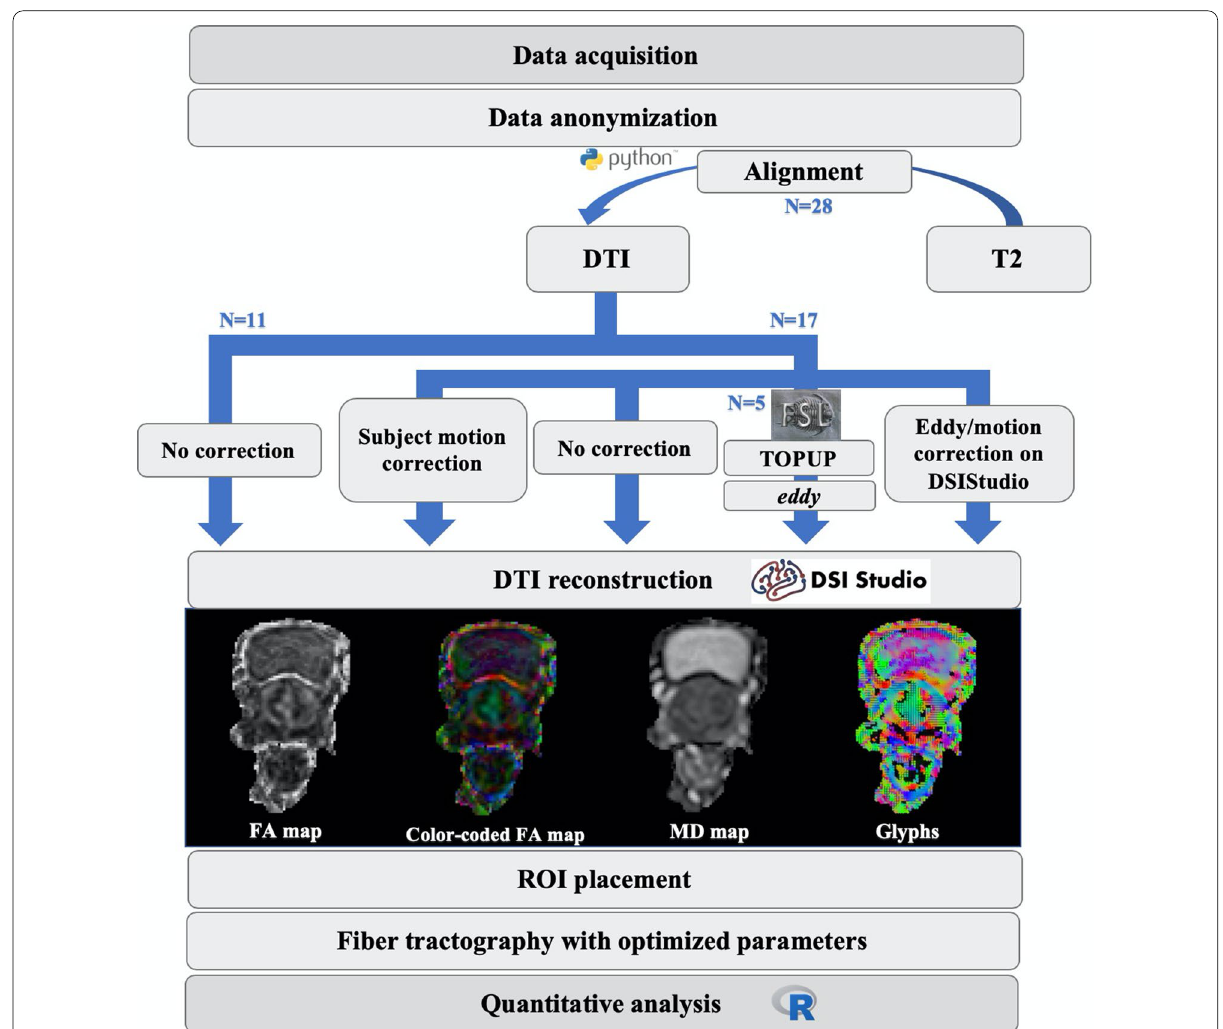
Fig. 6 Schematic representation on the study DTI processing and fiber tractography pipeline